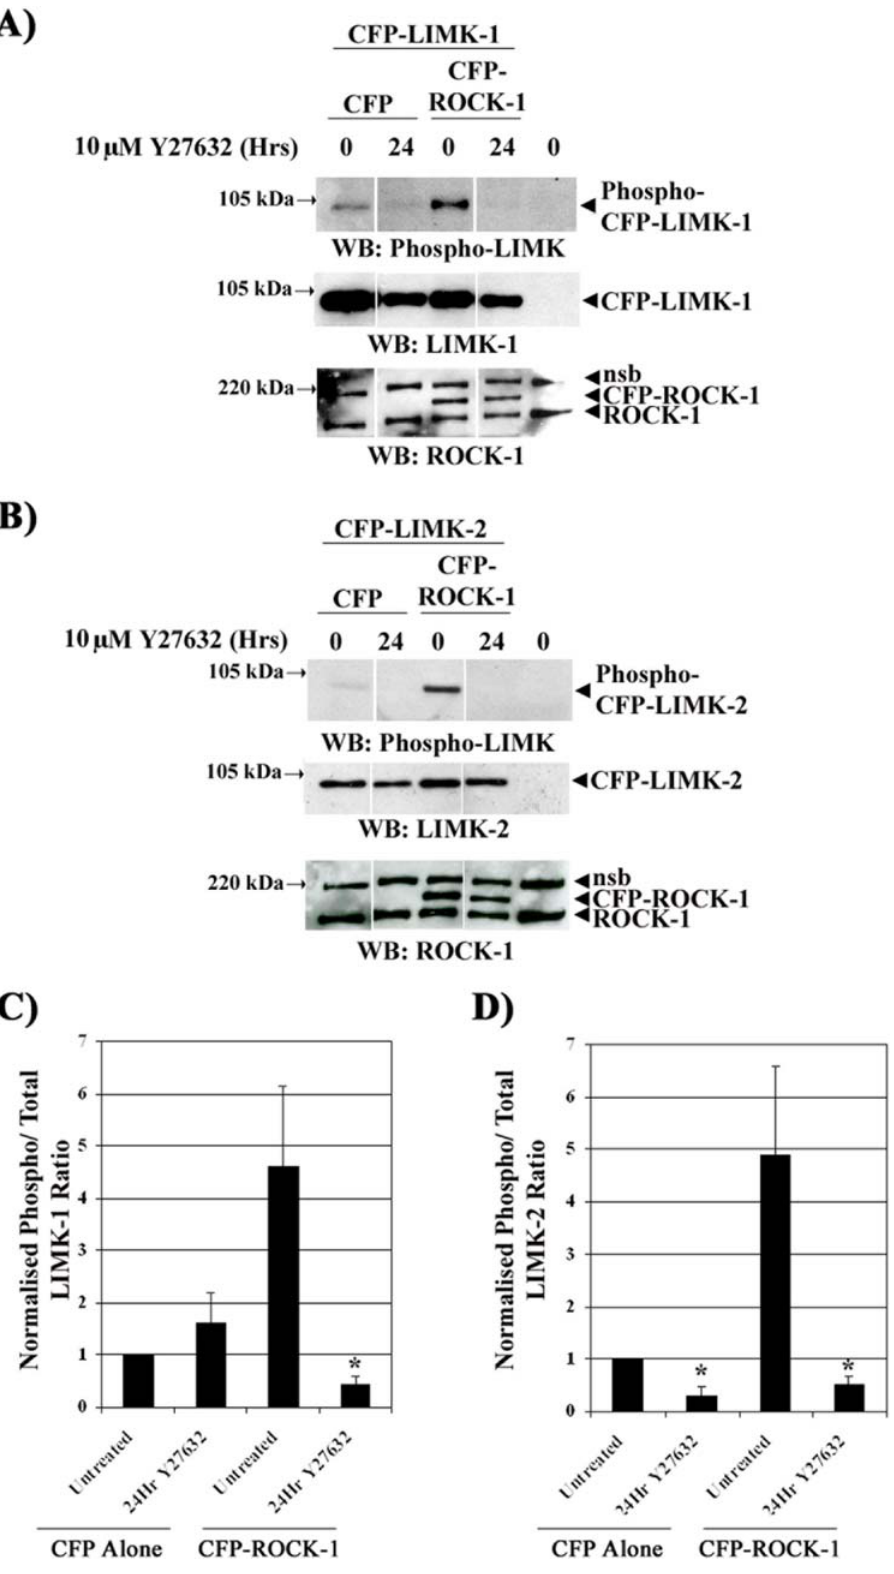
Figure 1. ROCK1 phosphorylates LIMK1 and LIMK2. A) and B) CFP-LIMK1 or 2 and either CFP-ROCK1 or CFP alone were transiently transfected into MDA-MB231 cells and treated with 10 m M Y27632 for 24 hours. The resultant lysates were immunoblotted using anti-phospho-LIMK, -LIMK1, - LIMK2 and -ROCK1 antibodies. (nsb=non-specific binding of the anti-ROCK1 antibody to a protein/s at 220 kDa). C) Ratio of phospho/total LIMK1 CFP-LIMK1 and D) Ratio of phospho/total LIMK2. (*=P , 0.05). doi:10.1371/journal.pone.0003398.g001 PLoS ONE |